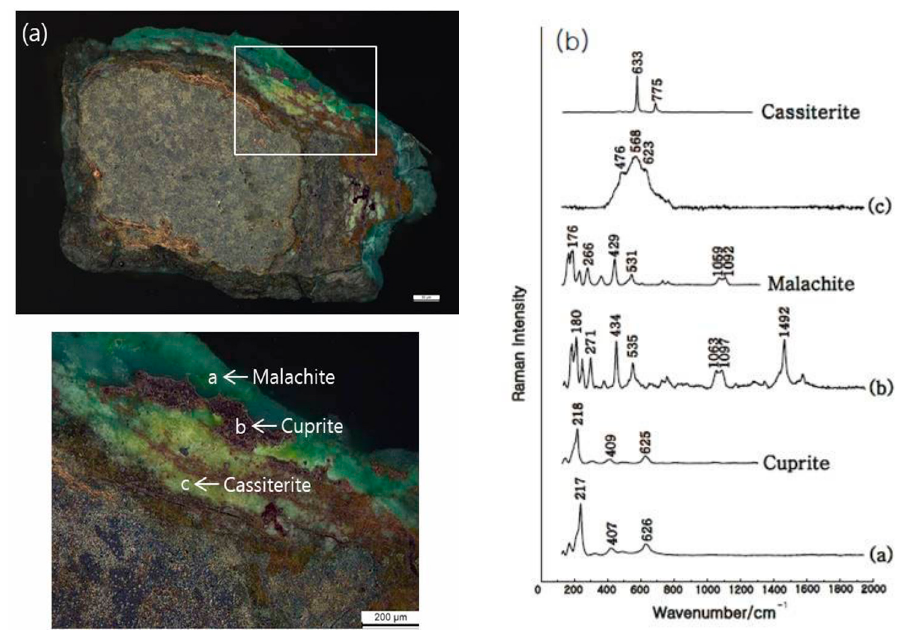
Figure 11. ( a ) Ga-35 (No. 3) corrosion layer darkfield (DF) images and ( b ) Raman spectrum.